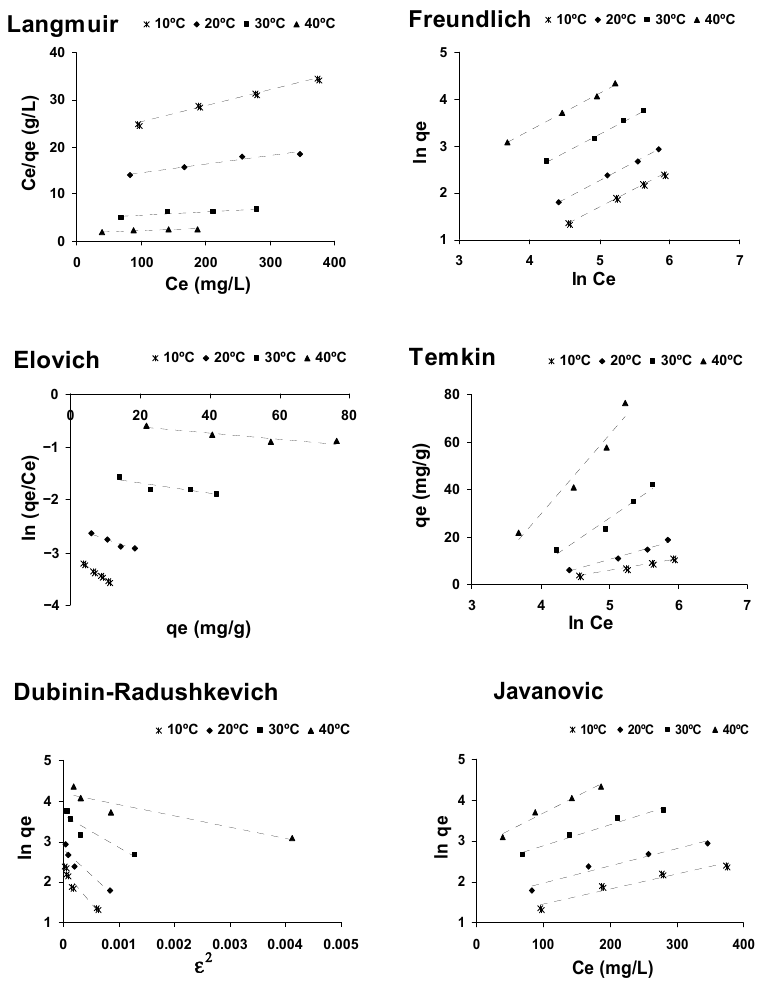
Figure 6. Isotherm plots for the adsorption of CPC onto AOS.